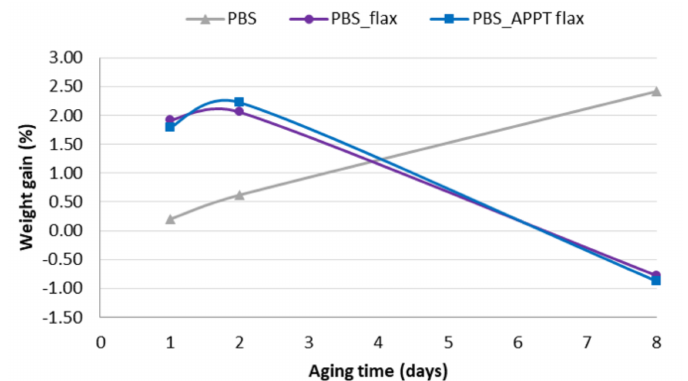
Figure 10. Weight gain of APPT treated and untreated PBS composites.